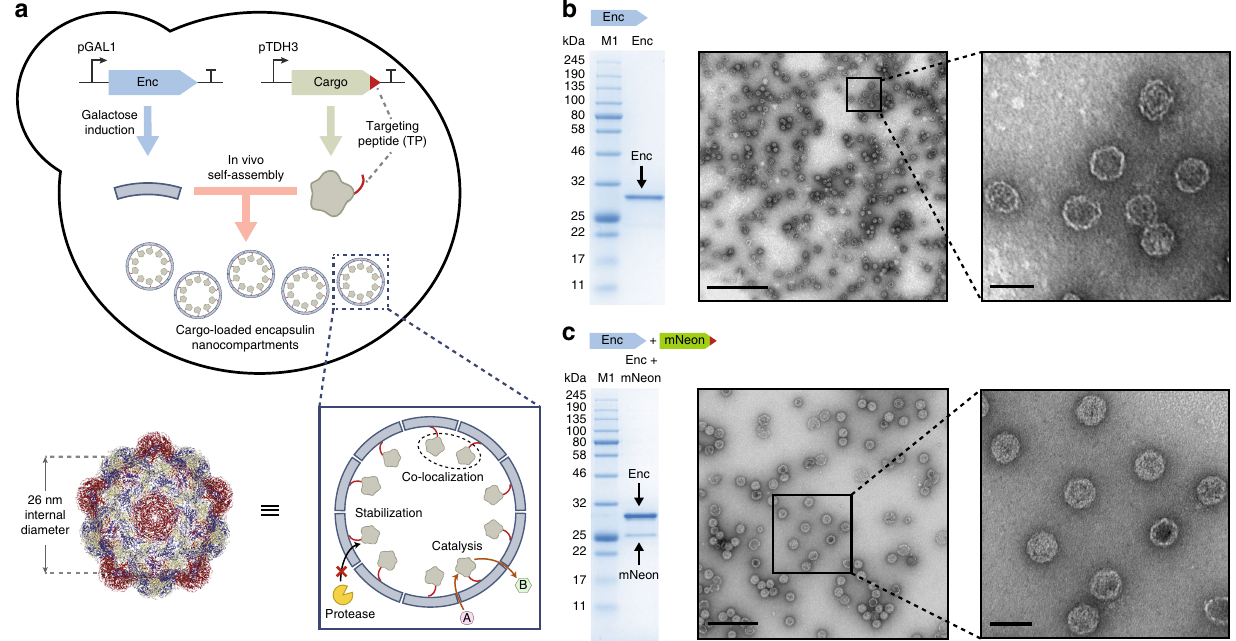
Fig. 1 Expression, assembly and cargo loading of encapsulins in yeast. a Co-expression of encapsulin and targeted cargo in yeast results in self-assembly of cargo-loaded nanocompartments, with an internal diameter of 26 nm (structure from PDB: 4PT2). Encapsulin compartments can stabilize and co-localize cargo proteins, as well as allow for catalysis to occur within their interior. b Encapsulin EncA (Enc, 32.5 kDa) from Myxococcus xanthus can be puri fi ed to homogeneity from yeast, as determined by SDS-PAGE and TEM. Full gel image is shown in Supplementary Fig. 1. Scale bars: zoom out: 400 nm, zoom in: 50 nm. c Heterologous proteins such as mNeonGreen (mNeon, 28.4 kDa) can be packaged inside encapsulin compartments, as determined by SDS-PAGE and TEM on the co-puri fi ed sample. Full gel image is shown in Supplementary Fig. 2. M1 = Color Prestained Protein Ladder, Broad Range (11 – 245 kDa, NEB). Scale bars: zoom out: 200 nm, zoom in: 50